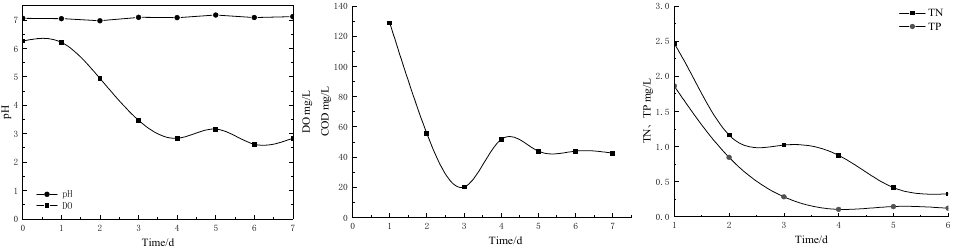
Figure 4. Variation in pH, DO, COD, TN, and TP of outlet water with time in the early stage of constructed wetland operation.